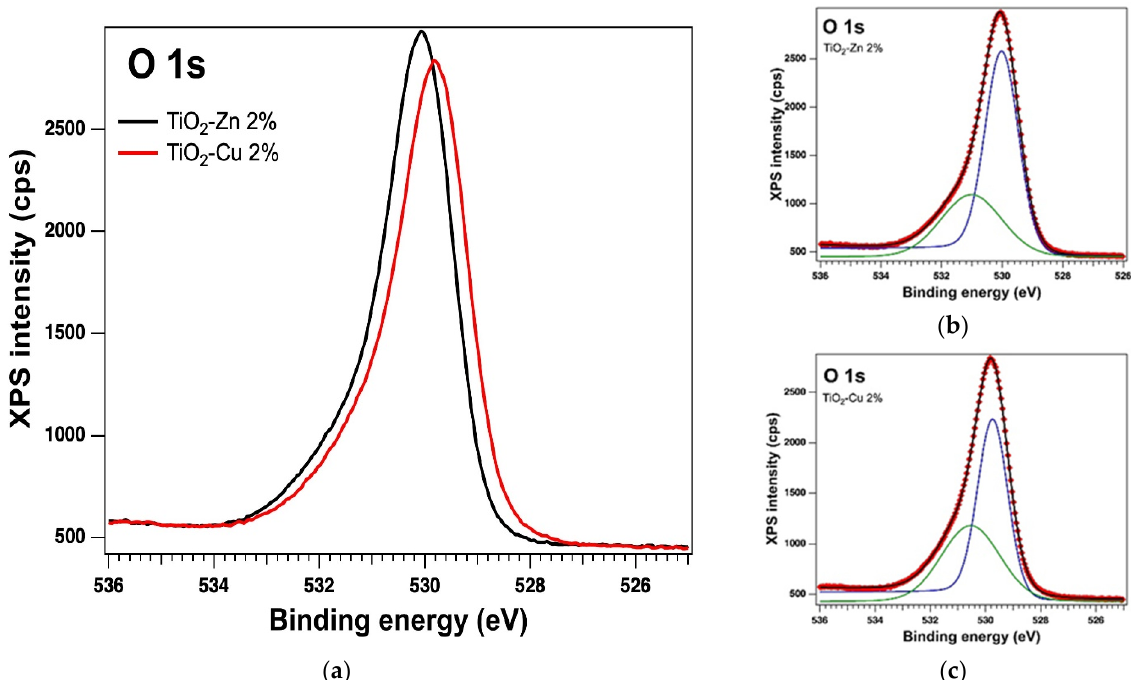
Figure 6. XPS spectra of the core level O 1s ( a ) overlayed XPS spectra of the samples prepared by the sol − gel method and the experimental data (red symbols) with the fit and deconvolutions given separately for ( b ) the sample with Zn and ( c ) the sample with Cu; deconvolutions: components C1–blue line and C2–green